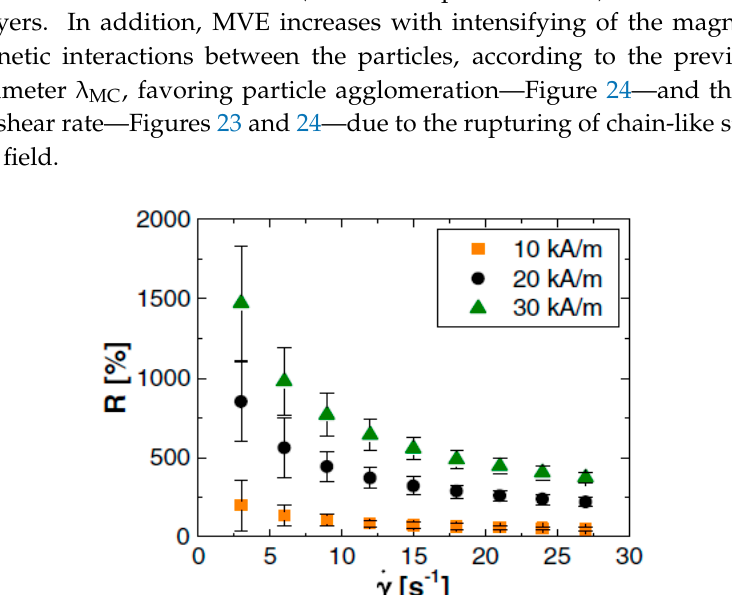
Figure 25. Newtonian viscosity of fluidMAG-DX-100 nm and FF054L samples without the influence of a magnetic field. Reprinted with permission from Reference [16]. The measurements revealed that the magnetorheology of these samples is quite similar; their behavior becomes shear-thinning and MVE is great and strongly dependent on magnetic field intensity—Figure 26.